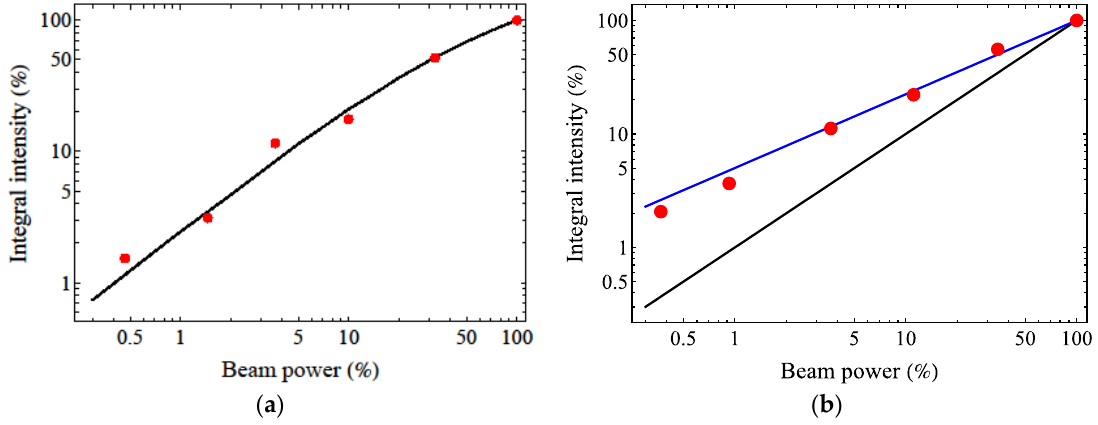
Figure 8. Scintillation yield versus beam power: ( a ) GYAGG:Tb; ( b ) GYAGG:Ce. For the Ce-activated sample, a deviation of the simulated dependence (black line in Figure 8b) and the line fitting the experimental data (blue line) is obvious, especially in the range of the low excitation power. Within the model, due to the short lifetime of the